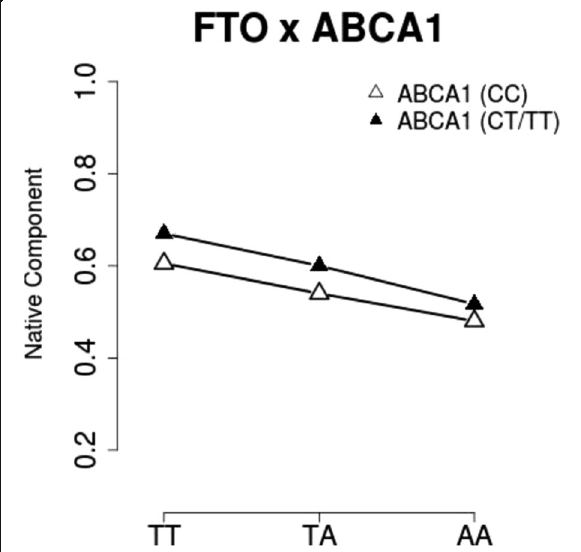
Fig. 2 Mean Native American ancestry proportion according to FTO rs99399609 genotype, stratified by ABCA1 rs9282541 genotype in 2354